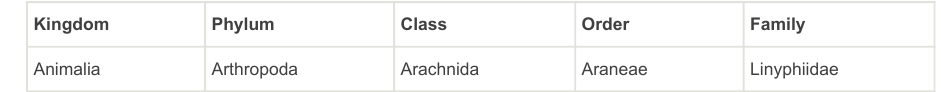
Kingdom Phylum Class Order Family Animalia Arthropoda Arachnida Araneae